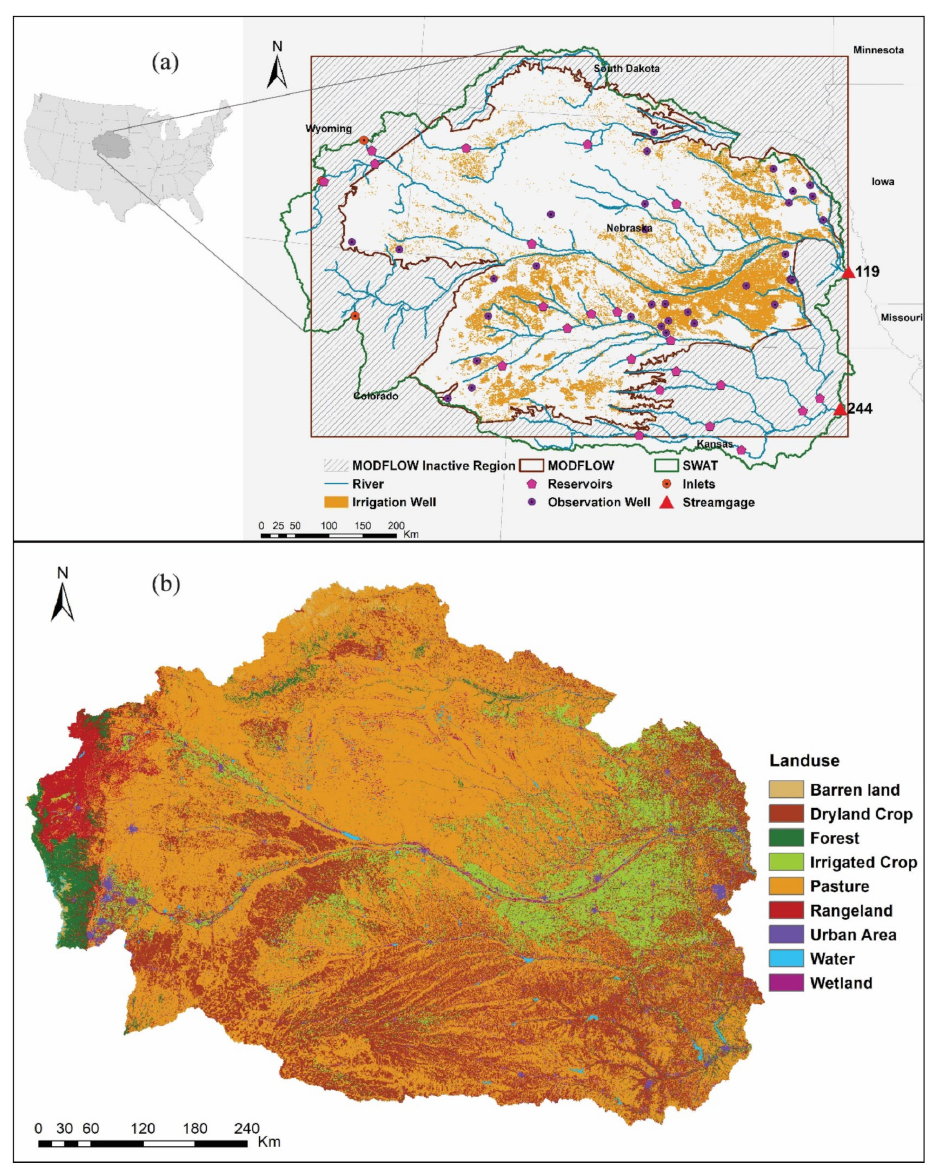
Figure 1. Modeling domains for SWAT and MODFLOW ( a ), and land use map ( b ), for the U.S. Northern High